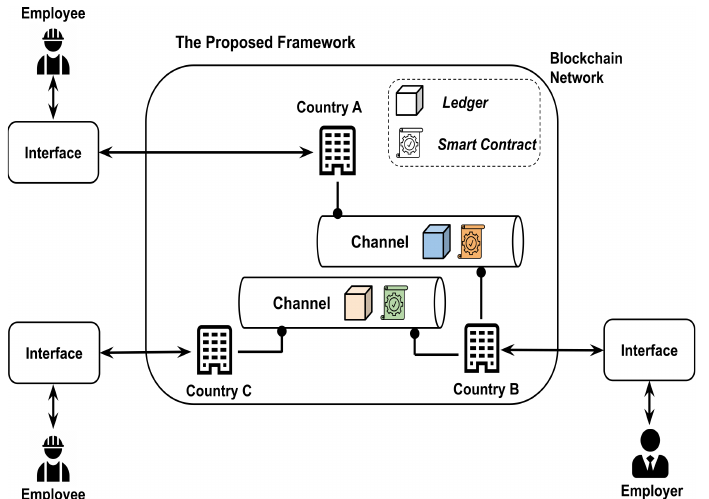
Figure 2. Framework